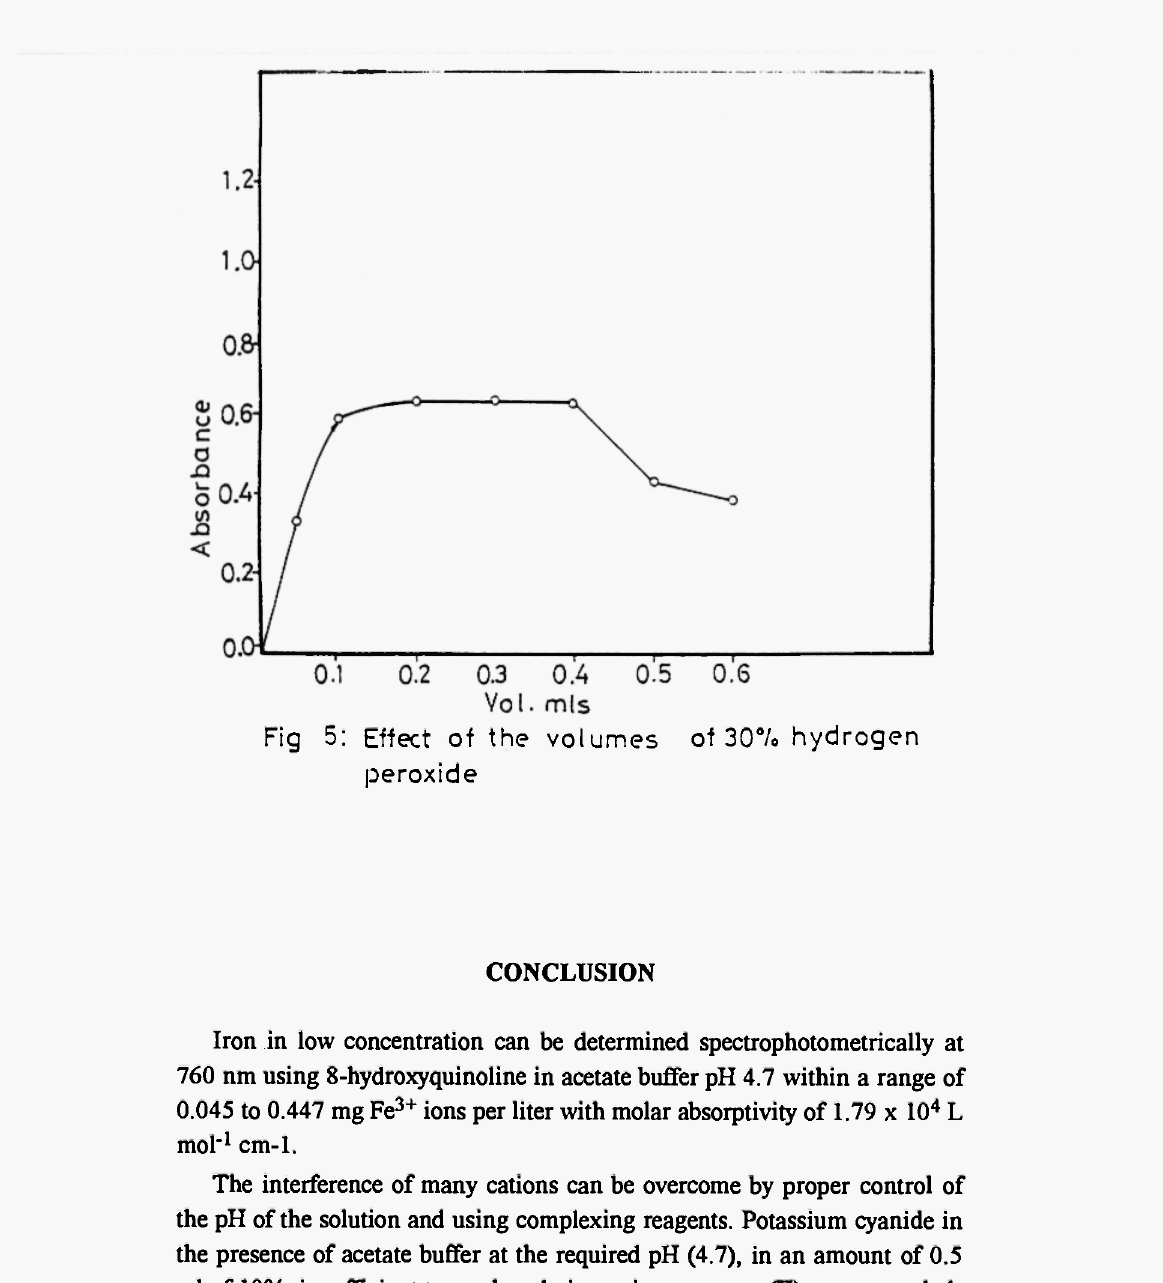
Fig 5: Effect of the volumes of 30% hydrogen peroxide